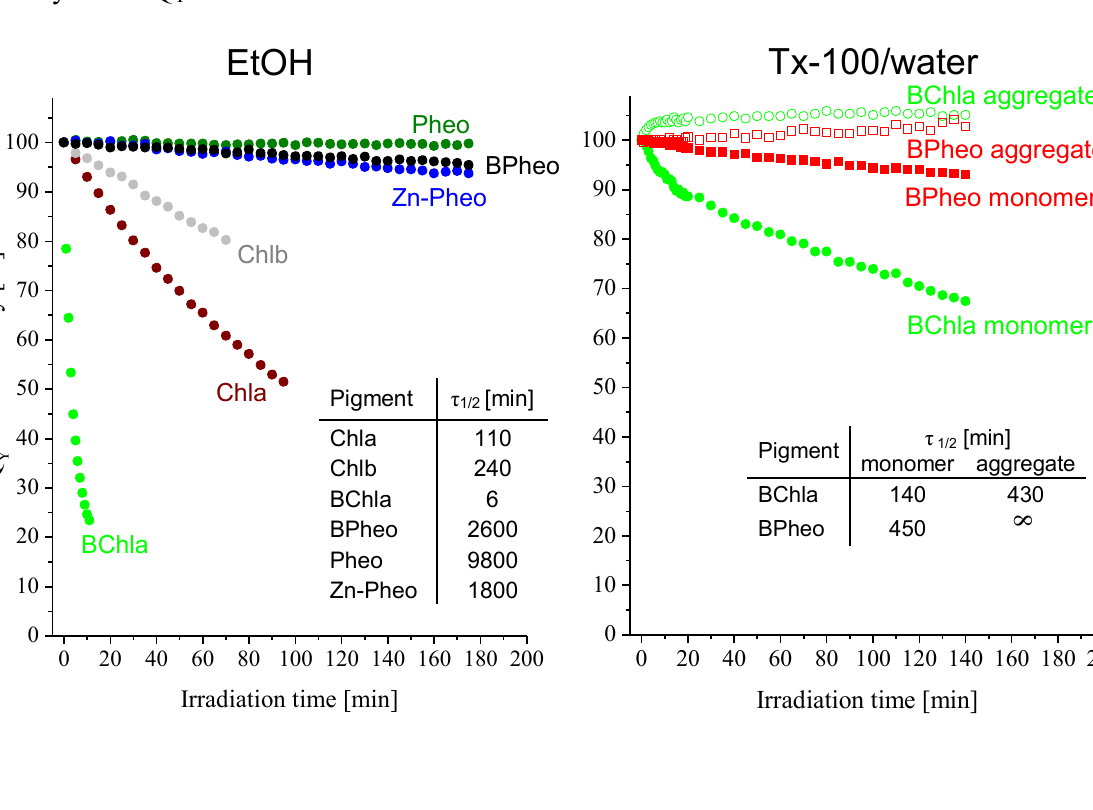
Figure 5. Photostabilites of Chla, Chlb, BChla, Pheo, and Zn-Pheo in EtOH (left), and of the BChla and BPheo aggregates in TX-100/water (right). The photostabilities of pigments are expressed as the decay of the lowest energy bands upon irradiation with red light (see text for details). Pigment half-lifetime ( τ ) was estimated as the time during which a 50% 1/2 decay of the Q band Y